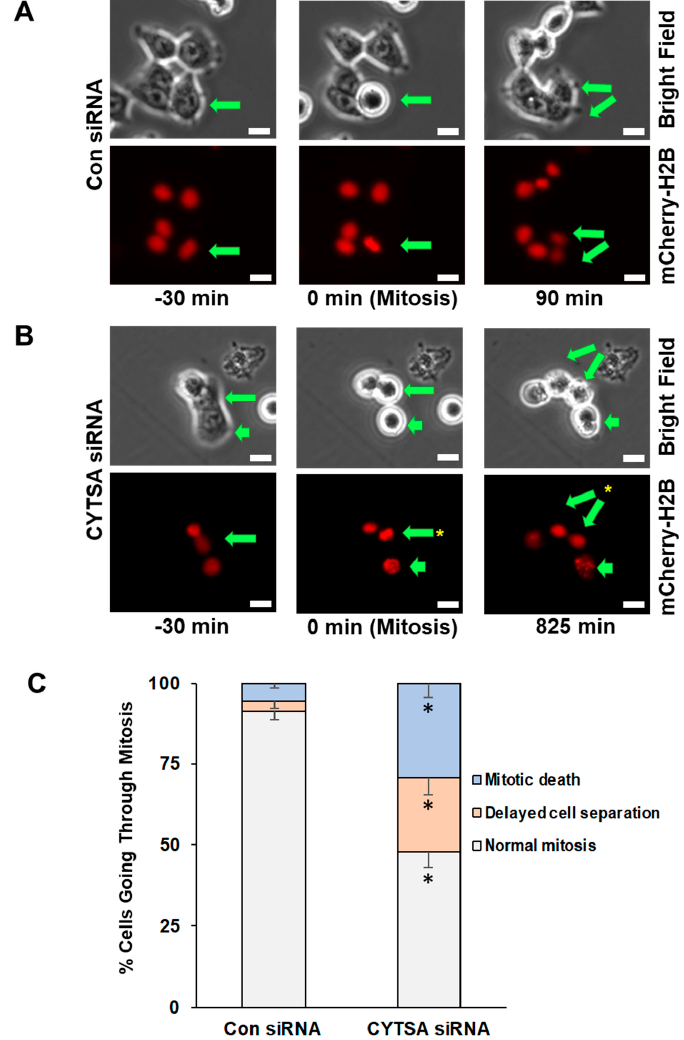
Figure 3. Depletion of CYTSA enhances mitotic cell death and post-mitotic CRC cell segregation. HCT116 cells that stably expressed mCherry-H2B were transfected with Con siRNA or CYTSA siRNA and grown for 40 h; real-time imaging was performed for the next ~24 h at 15 min intervals. Bright-field (top) and fluorescence images (mCherry-H2B; bottom) were obtained. ( A ) Sequence of images of Con siRNA-treated cells are shown. A CRC cell that goes through mitosis is indicated by an arrow. The cell initially in interphase (left panel) enters mitosis as determined by condensation of the DNA or circular phenotype (middle panels) and completes cell division (daughter cells marked by arrows, right panel). Time (in minutes) at which the images were obtained is shown below the images. Scale bar = 20 µ m. ( B ) Sequence of images of CYTSA siRNA-treated cells are shown. Mitotic cells, as determined on the basis of metaphase DNA or a circular phenotype, are marked by arrows (middle panels). Non-separated daughter cells (marked by two arrows) are shown (right panels). A different mitotic cell (short arrow) that undergoes DNA fragmentation and cell membrane blebbing is also shown (right panel). Time (in minutes) at which the images were obtained is shown below the images. Scale bar = 20 µ m. ( C ) Percentage of mitotic cells going through; (i) normal mitosis, (ii) showing delay in daughter cell separation, or (iii) with evidence of mitotic death were plotted for CRC cells transfected with Con siRNA or CYTSA siRNA. Note: Significant differences were found for similar outcomes (e.g., normal mitosis) when compared between Con siRNA vs. CYTSA siRNA-treated cells. * p <